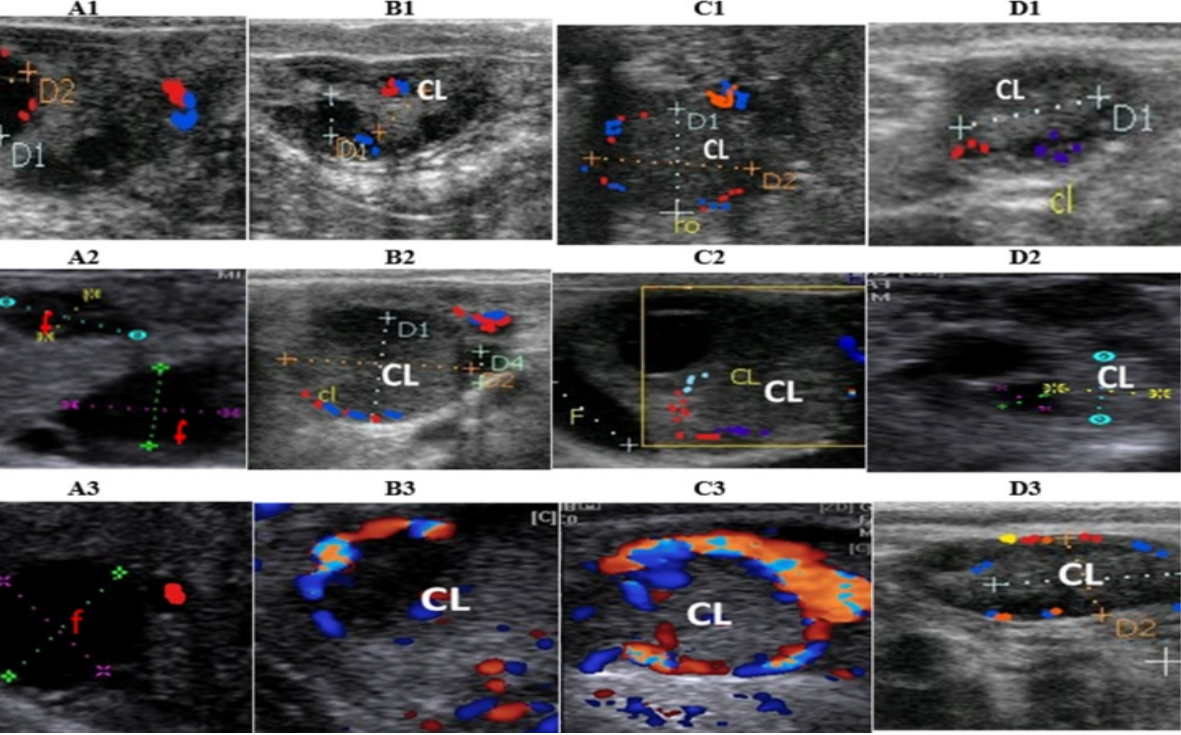
Figure 1. B-mode and colored ultrasonograms showing the preovulatory dominant follicle (Follicle: f; A1 , A2 , and A3 ) at the follicular phase and corpus luteum (CL) on days 5 ( B1 , B2 , and B3 ), 10 ( C1 , C2 , and C3 ), 15 ( D1 , D2 , and D3 ) at the luteal phase in GPG, NGPG, and HNGPG protocols, respectively. Blue colored areas refer to the blood flow away from the probe (blood supply towards the organ/tissue) and red colored areas refer to the blood flow towards the probe (blood return from the organ/tissue towards blood